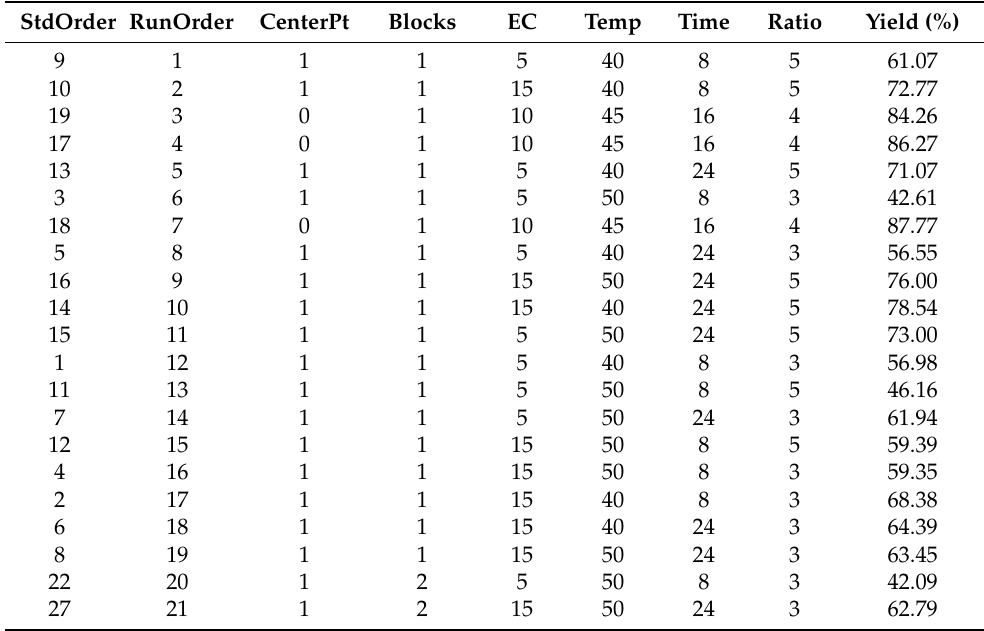
Table 1. Biodiesel conversion yield from enzymatic transesterification of Atlantic salmon oil. StdOrder